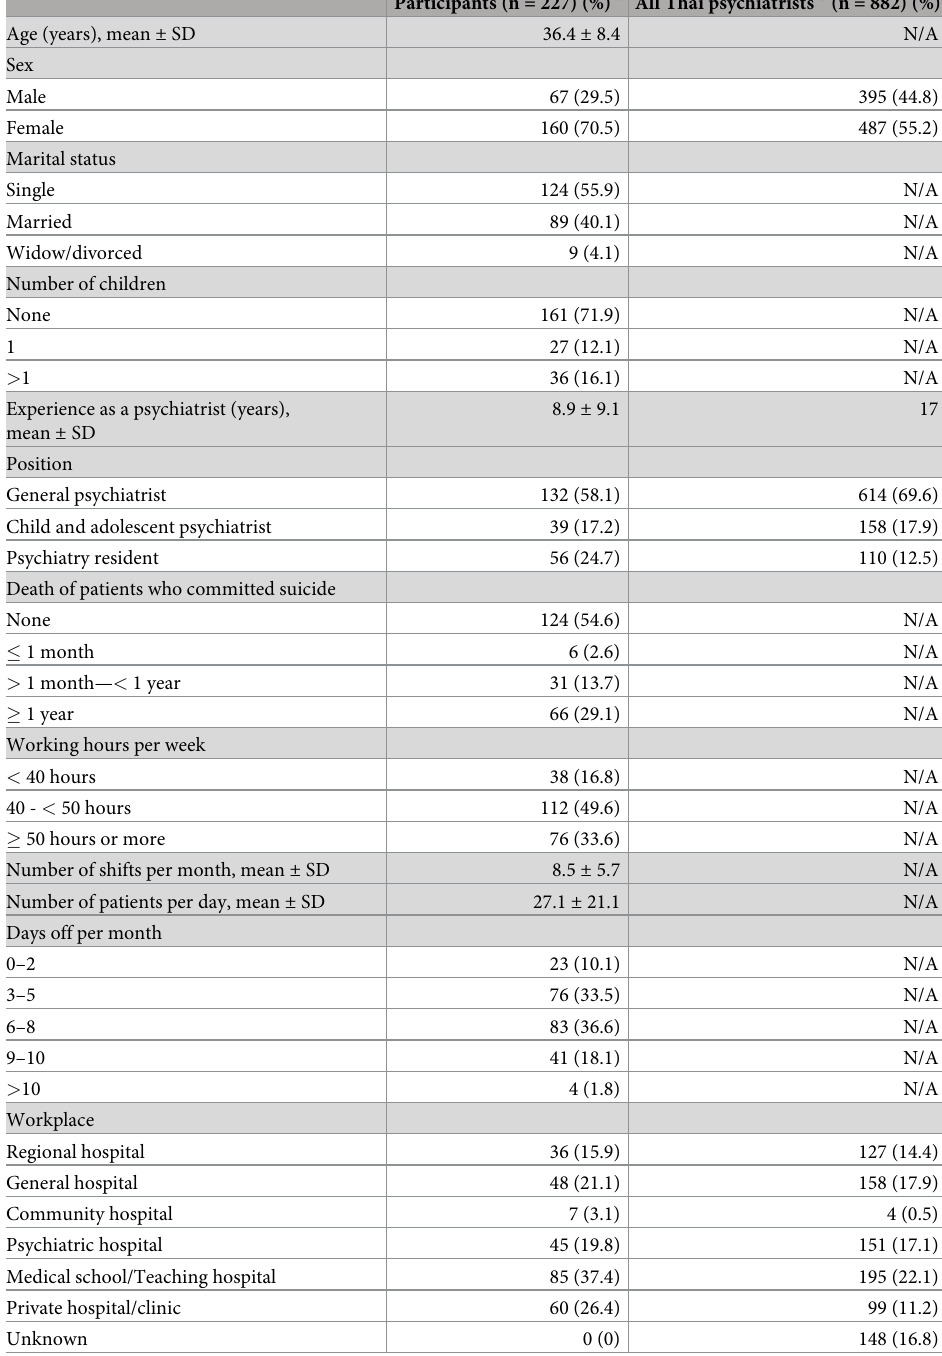
Table 1. Sociodemographic variables and work-related aspects of